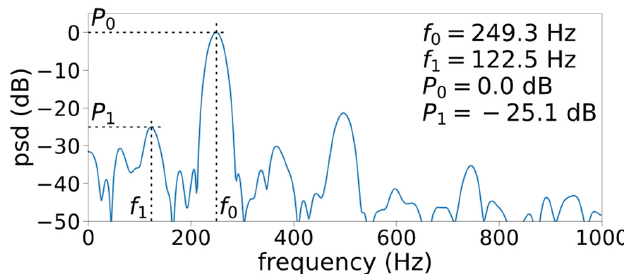
Figure 6. Case 3 periodogram at 𝑡 = 0.075 (7th window).